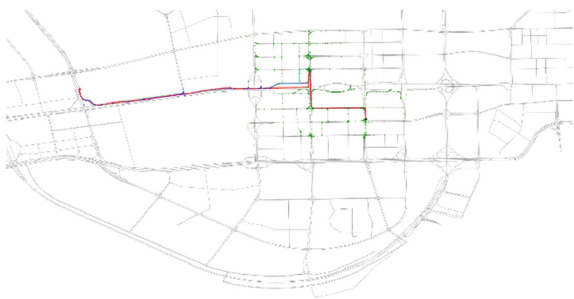
Figure 6: Charging path planning by EHBMA.